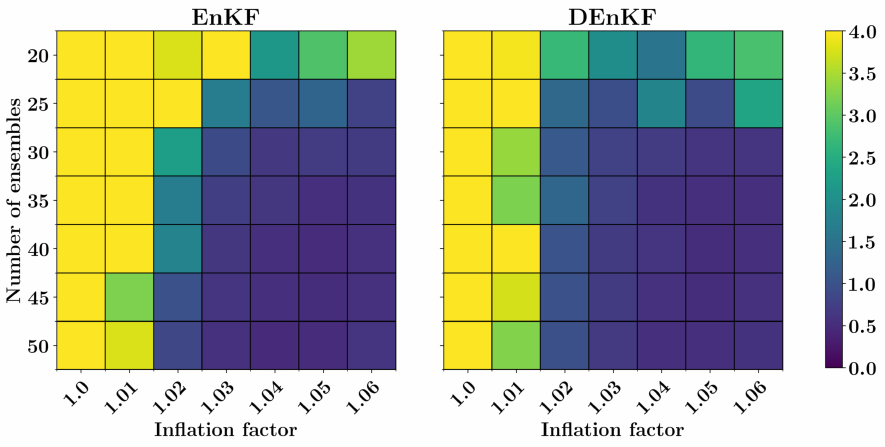
Figure 9. RMSE for a two-level Lorenz model for different combinations of number of ensembles and inflation